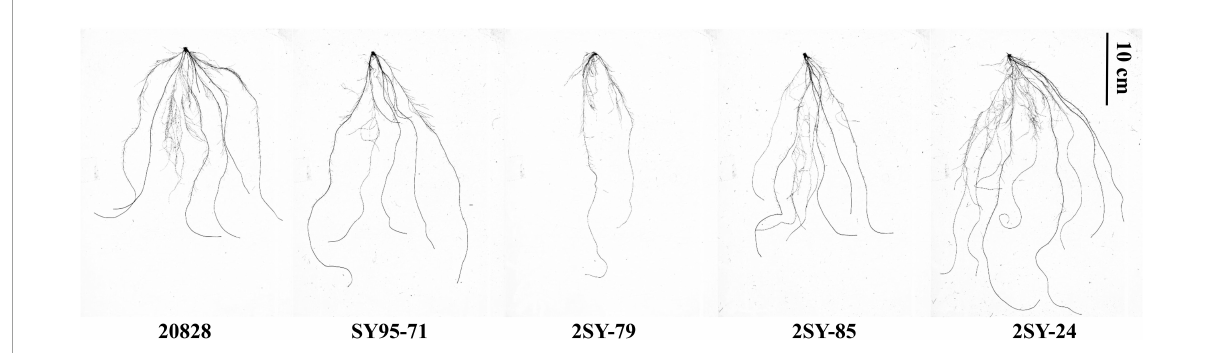
FIGURE1 Root morphology for the parents and partial lines.